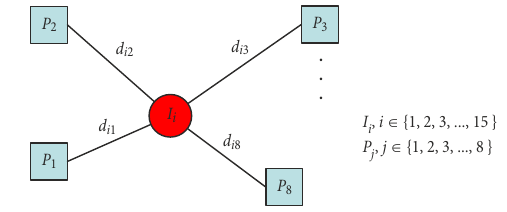
Figure 1. Symbolic display between the sources and